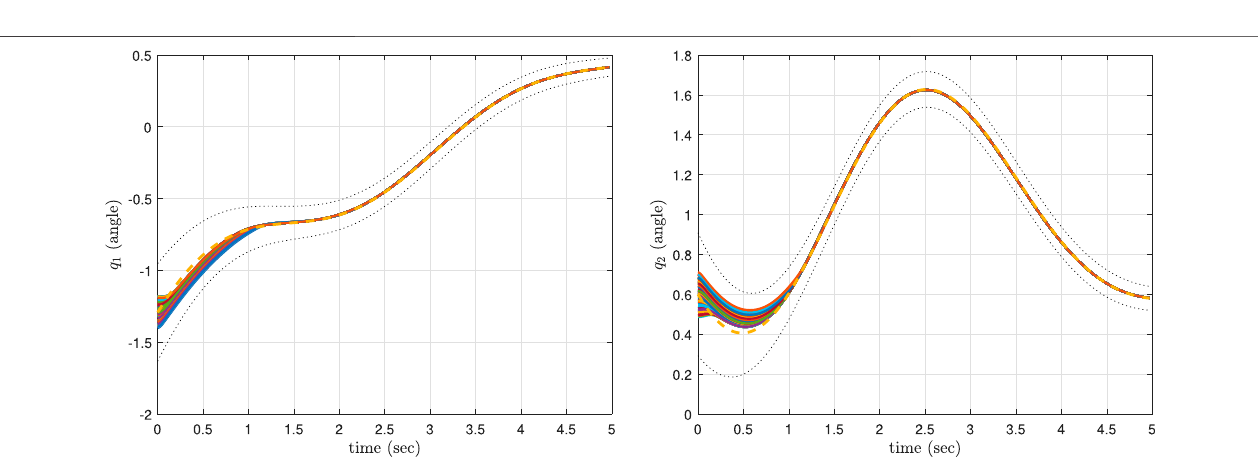
FIGURE 6 | The results of the CLF/CBF-based ProMP controller with more priority given to the CLF than the CBF for the fi rst joint (left) and second joint (right).